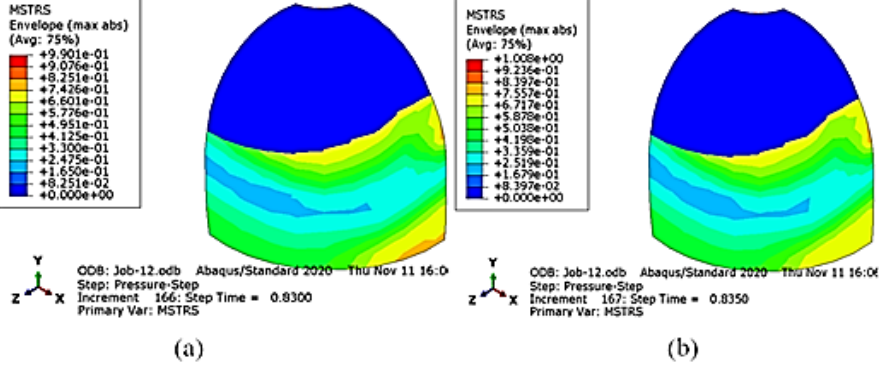
Figure 9. Maximum stress failure index: ( a ) lower than 1 at load step 0.83 and ( b ) greater than 1 at load step 0.835.